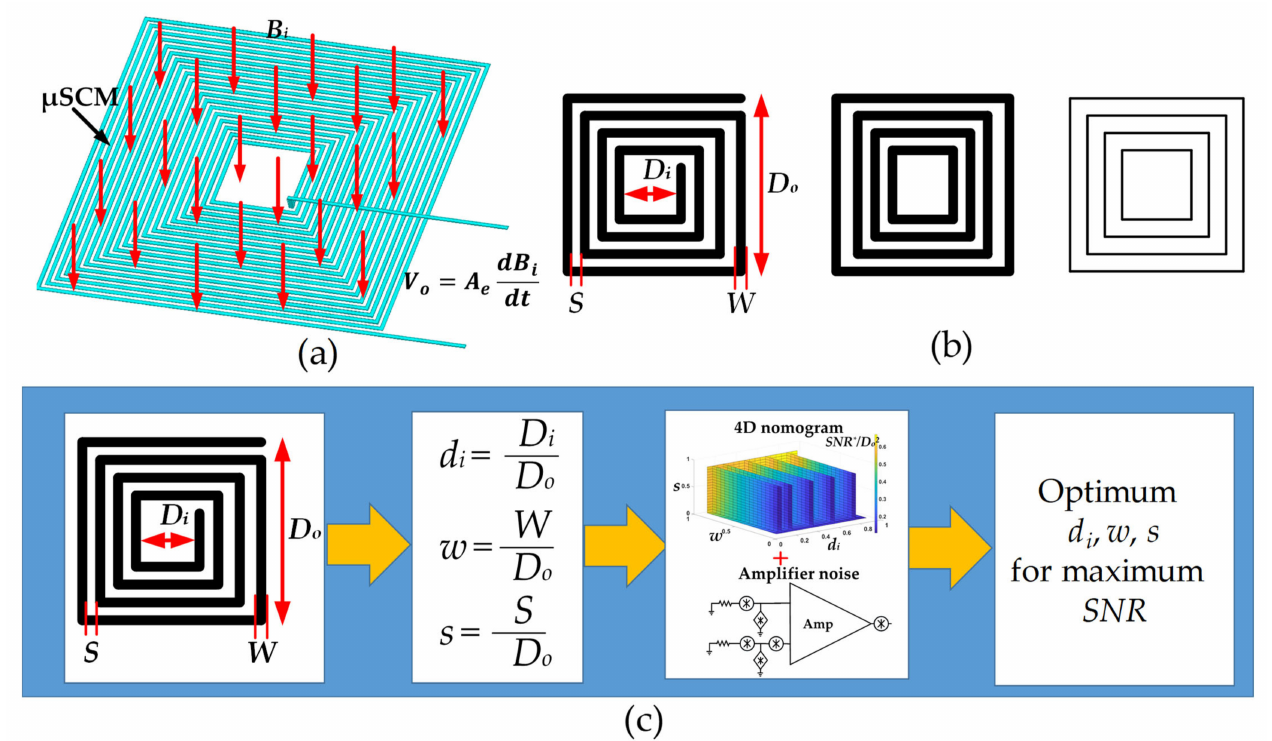
Figure 1. ( a ) Working principle of µ SCM. ( b ) Approximation of a spiral inductor with closed areas and its layout parameters. ( c ) Optimum design methodology to achieve maximum SNR